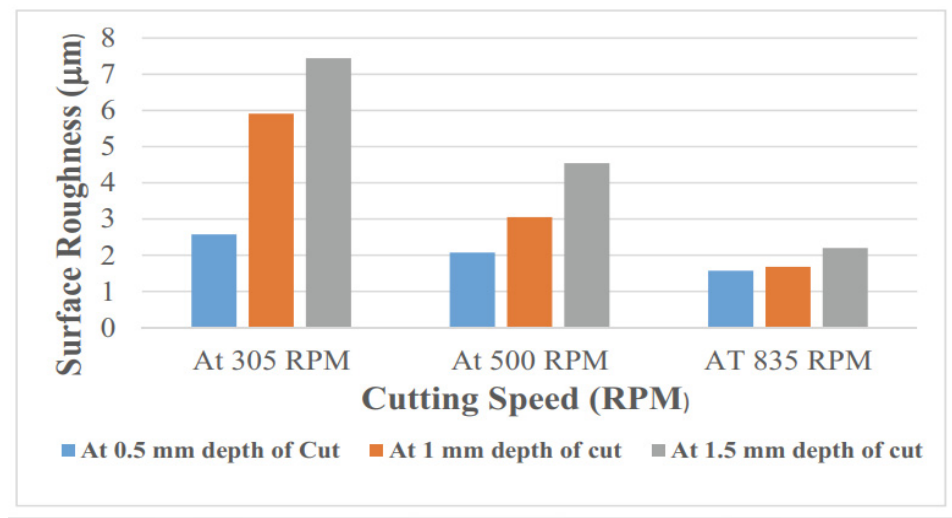
Figure 4. Relation of Cutting Speed and Depth of Cut with Surface Roughness [83].